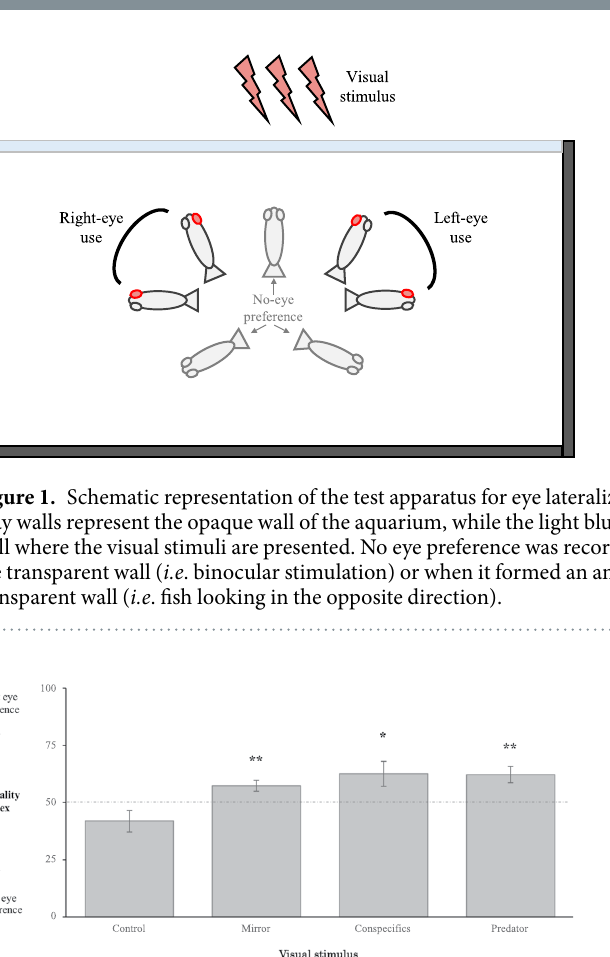
Figure 2. Left-right eye preference of A. triostegus larvae during the inspection of visual stimuli in an adjacent aquarium. Figure represents LI mean ( ± SE) values. Asterisks indicate significant differences (Mann-Whitney U tests, * p < 0.05; ** p < 0.01) between Laterality Index (LI) values and the theoretical 50% value (dotted line). 13 to 14 replicates (one fish per replicate) were conducted for each visual